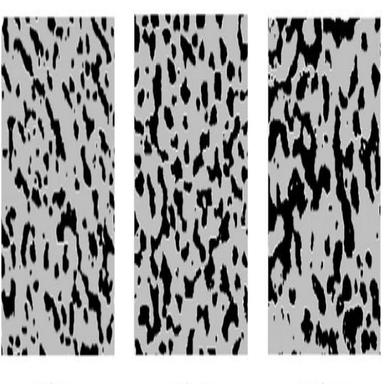
Representative microstructures of the lead-tin alloy (Pb37Sn63) at 175 C for different times. The dark region represents lead-rich phase and white region represents tinrich phase. The linear size of the microstructure is ~100 mm. The resolution of the image is 600 by 600 pixels.